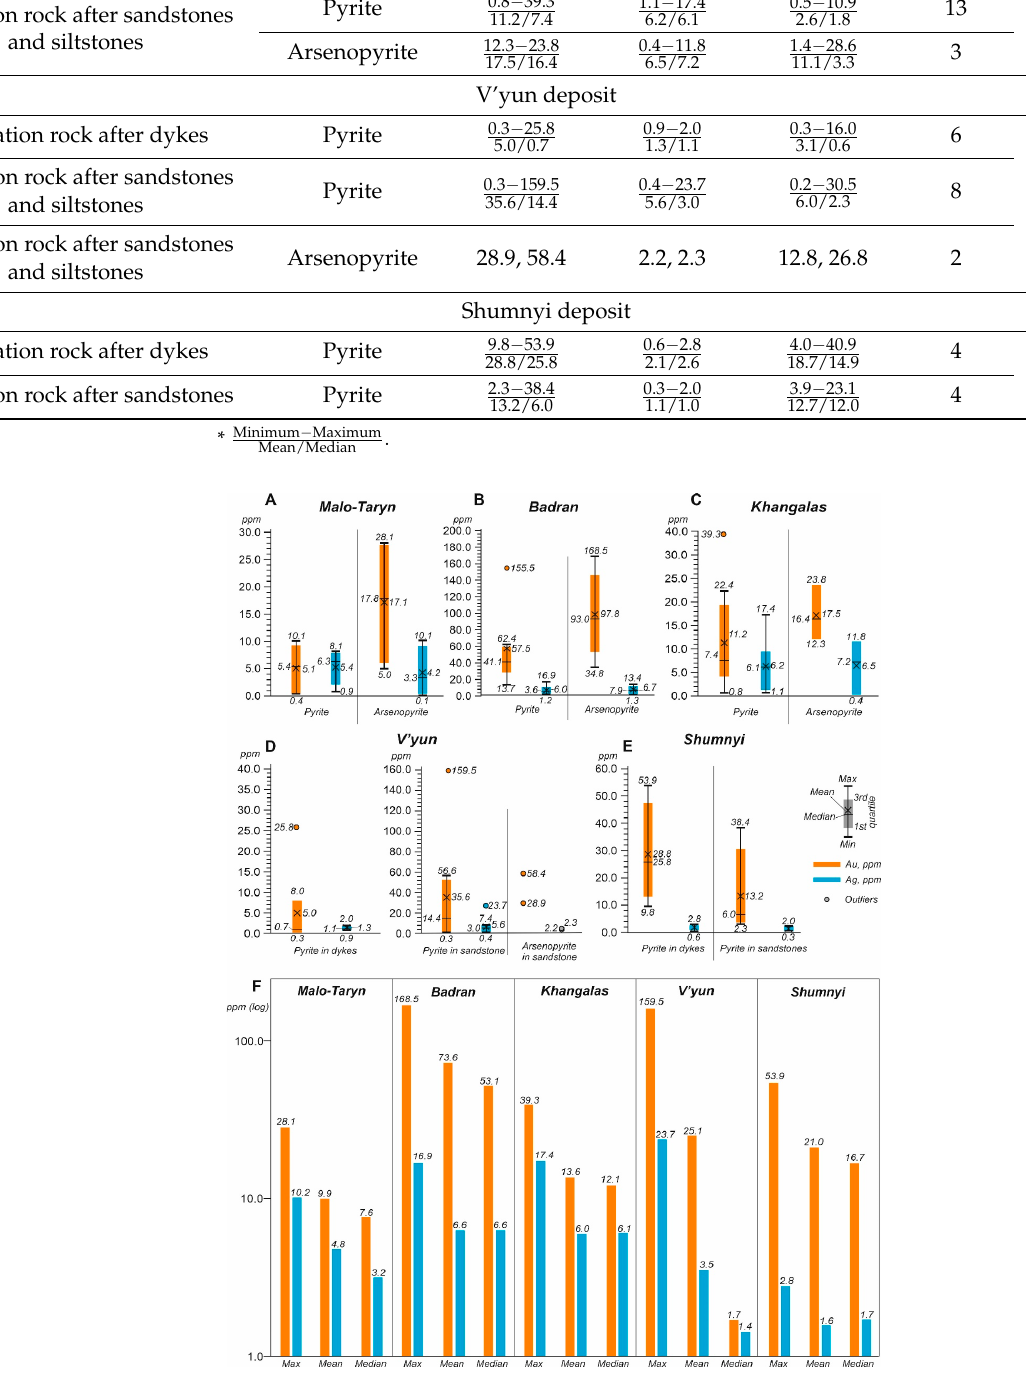
Figure 15. The gold and silver content in sulfides from the alteration of the studied OGDs, central YKMB: ( A ) Malo–Taryn; ( B ) Badran; ( C ) Khangalas; ( D ) V’yun; ( E ) Shumnyi; ( F ) comparative diagrams between the maximum, mean, and median values of the gold and silver content in sulfides from the alteration.